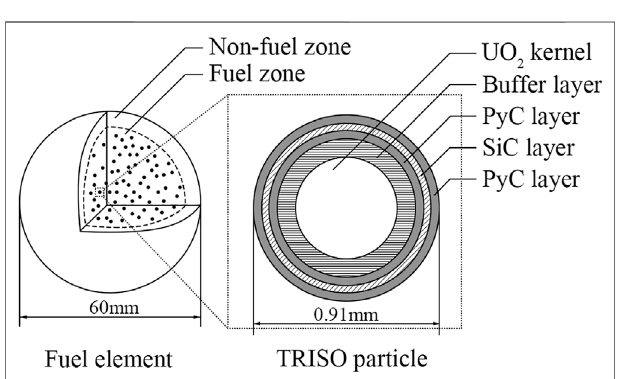
FIGURE 3 | HTR-10 spherical fuel element (IAEA,